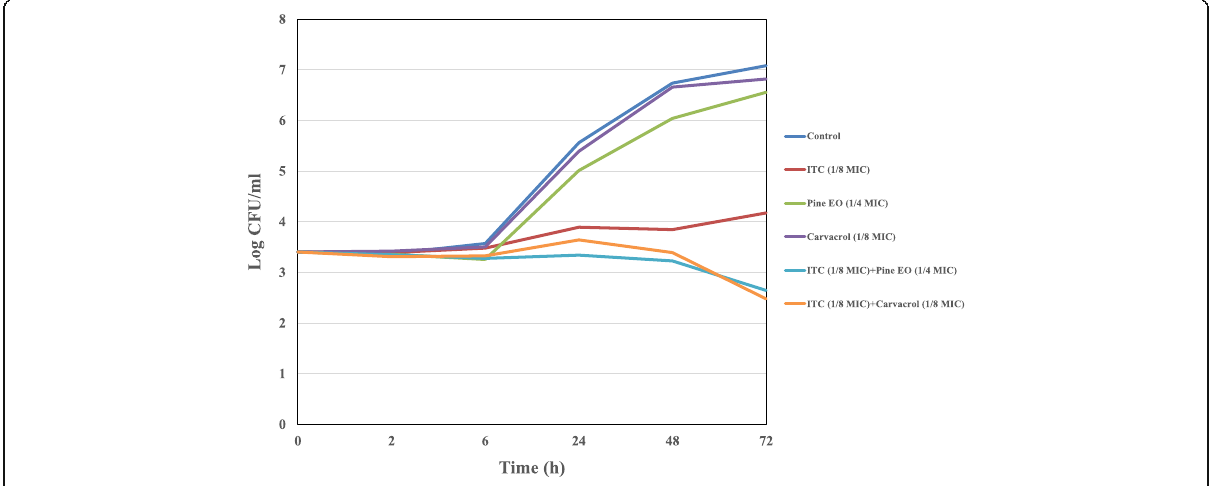
Fig. 4 Time-kill curve of ITC, pine EO and carvacrol alone and in combination against C.neoformans ADS 37 (azole-susceptible strain)